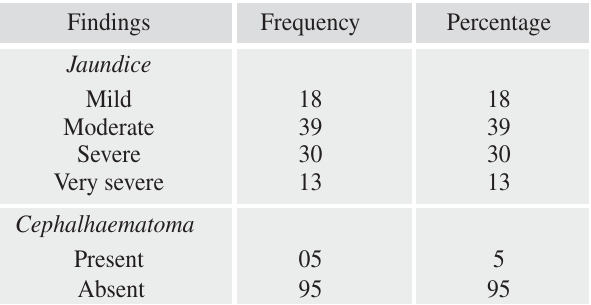
Table II: Distribution of patients by clinical examination findings